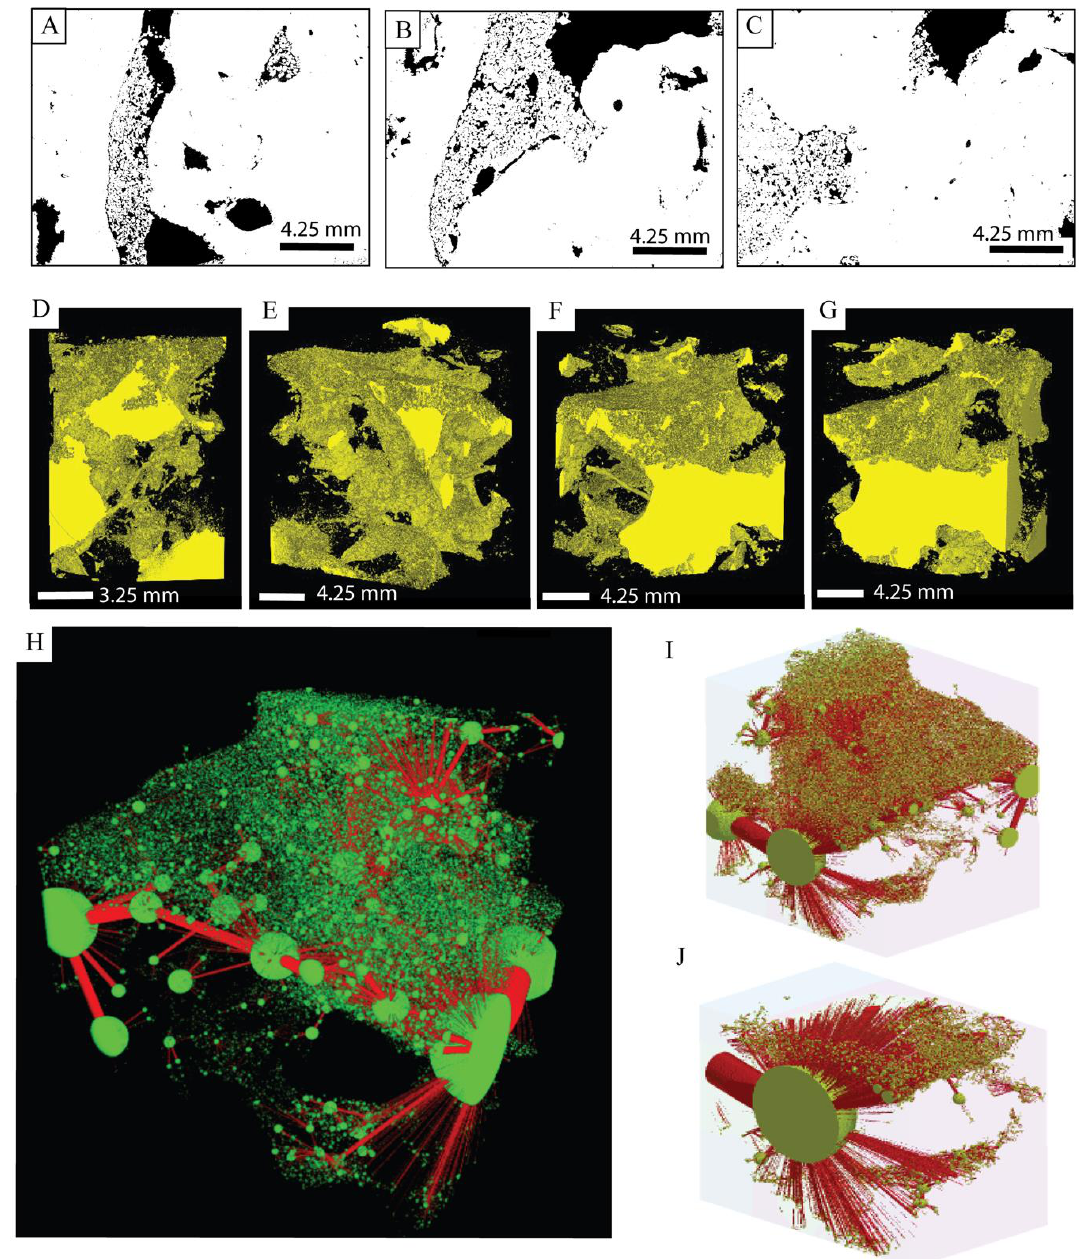
Figure 8. ( A – C ) Binarised slices through X-ray tomographic reconstruction of the Rathlin sample, black = pores, white = solid. Images 1341 by 1020 pixels, ~13 µm per pixel. ( D – G ) 3D reconstructions of porosity (yellow), at various rotations, from the same scan as in ( A – C ). Full movie of 3D reconstruction available in Supplementary Materials. ( H – J ) Ball and stick models of pore connectivity used to model permeability; balls representing pores, and sticks pore throats, with size indicating relative size. ( H , I ) overviews of whole sample at different orientations, ( J ) enlargement of ( I ) illustrating connection of small pores to the larger pore system.